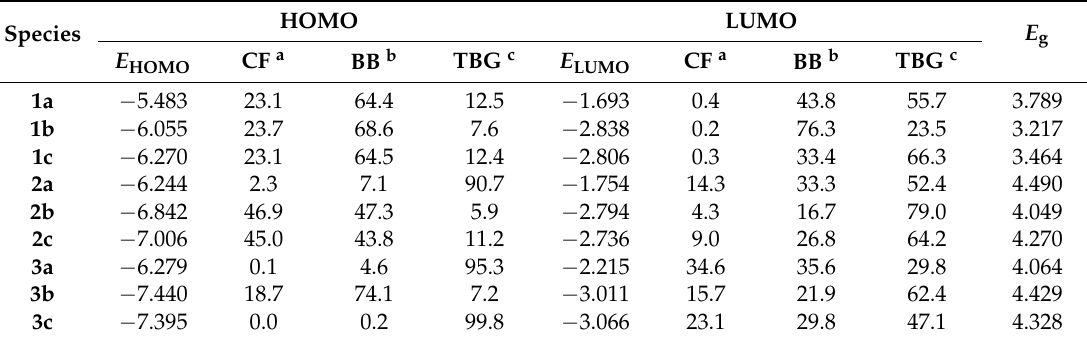
Table 1. The FMO energies E HOMO and E LUMO , E g (eV), and HOMO and LUMO contributions (%) of the designed